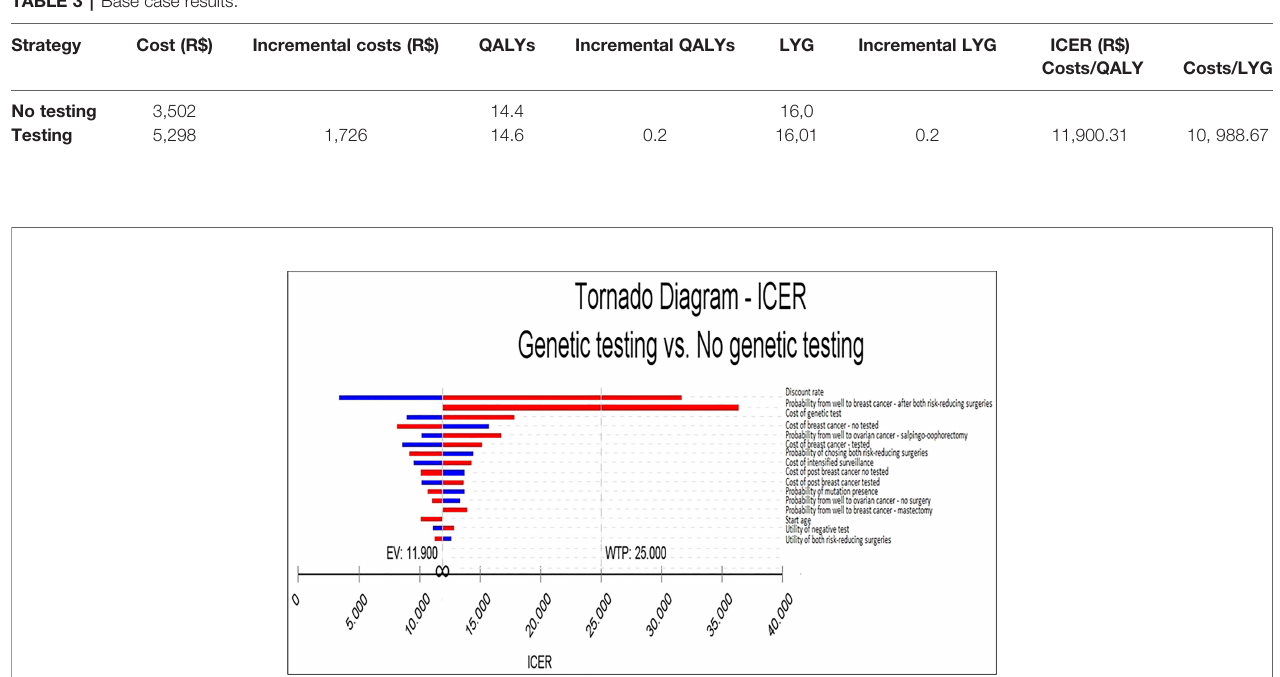
FIGURE 3 | Deterministic sensitivity